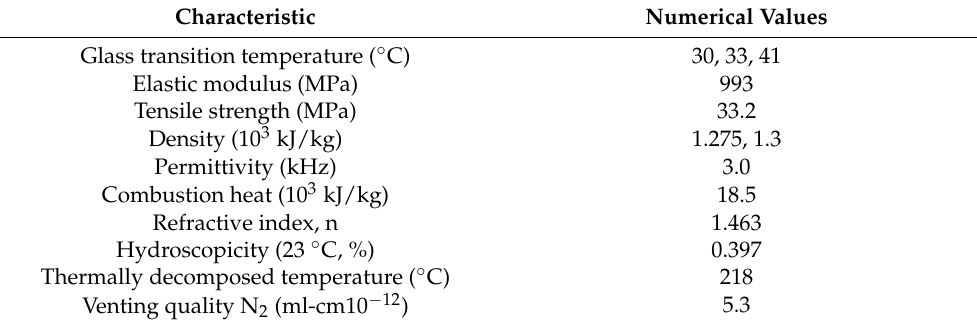
Table 4. Performance of PPC [55].